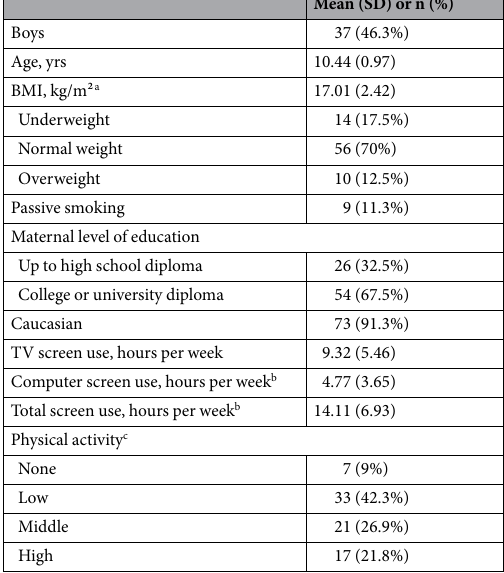
Table 1. Demographic characteristics of the study population (n = 80). a BMI categorization based on age and gender specific children’s growth curves for Flanders 2004; b n = 77 (included in the analysis); c low: ≤ 3 hours, middle: > 3 and < 6 hours per week, high: ≥ 6 hours per week, n = 78.